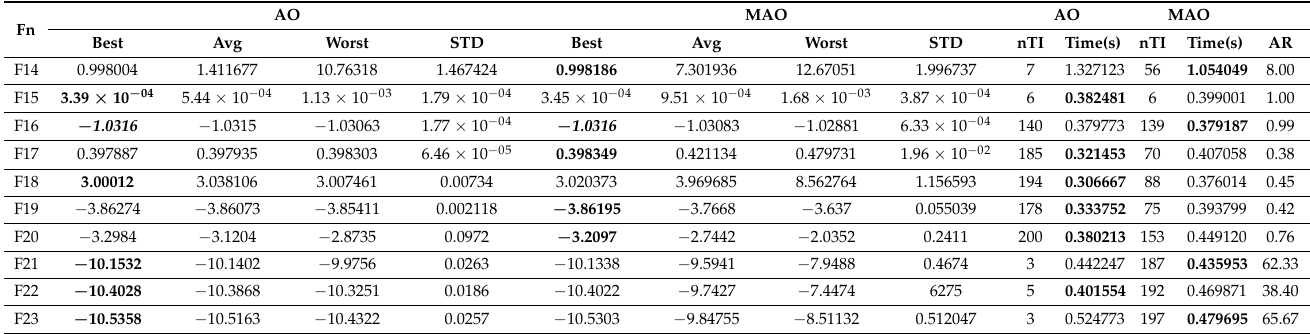
Table 9. Results obtained for fixed-dimensional benchmark